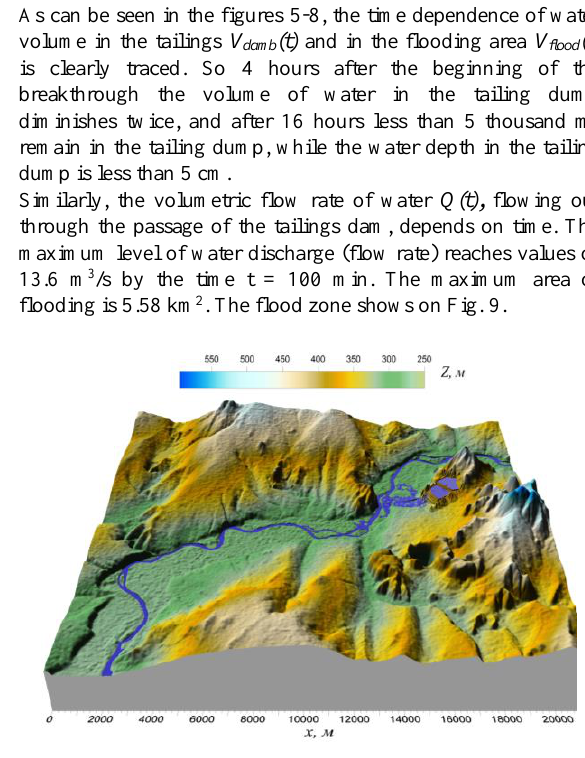
Figure 9. Flooded area during the development of a hydrodynamic accident at the tailings dump of the concentrator on the three-dimensional map, scale 1: 25 000